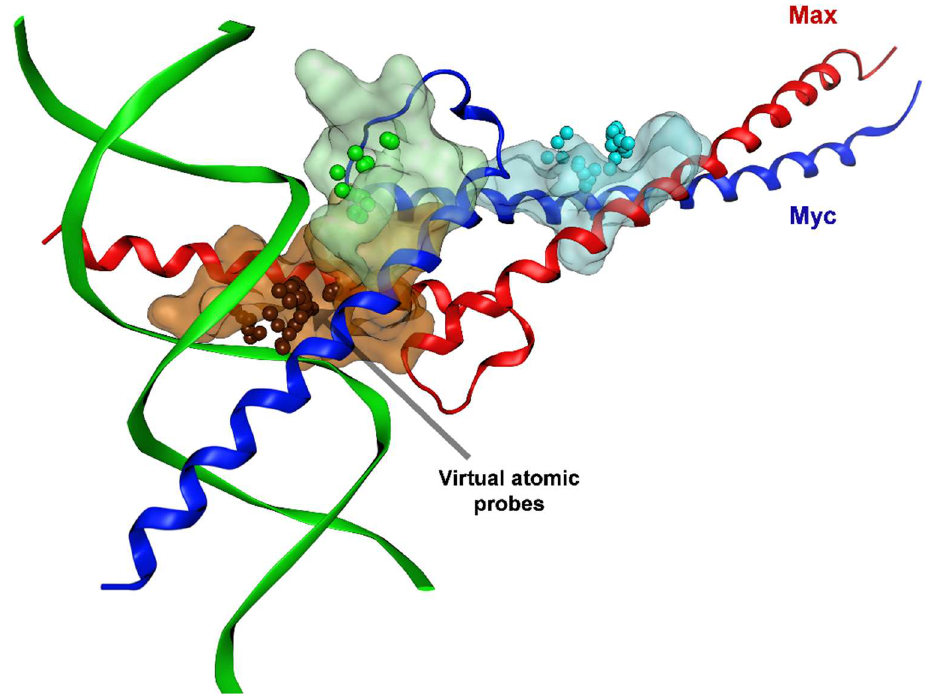
Figure 14. Three independent binding sites identified in silico at the Myc-Max/DNA and Myc-Max dimerization interfaces (colored meshed surfaces). The sites were identified by probing the surface with virtual atoms (colored alpha spheres within the three found pockets). The image was generated with Molecular Operating Environment (MOE). See text for details.